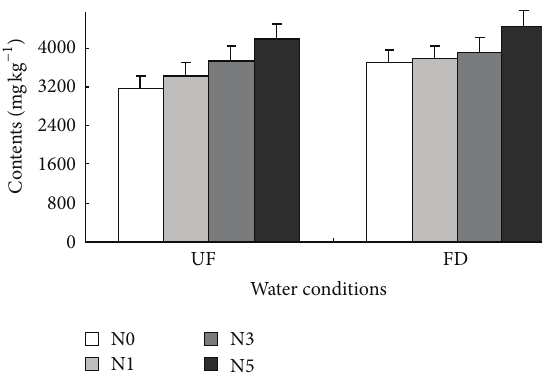
Figure 5: Effects of N-deposition on the wetland soil LBC.